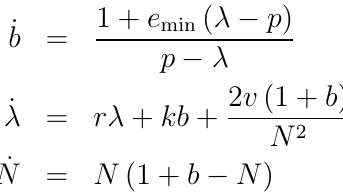
Figure 3. Multiple steady states and intertemporal equilibria due to (dynamic) norms of the example (30) and the parameter values: r = 0 . 5 , e